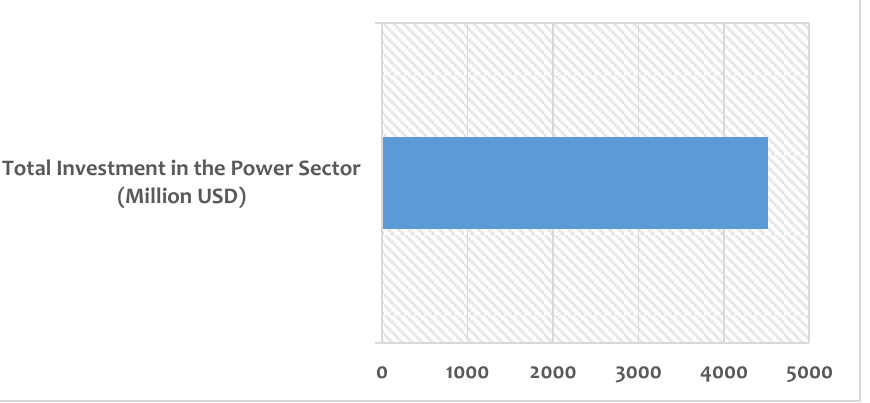
Figure 7. Renewable energy in the NDCs of the UAE. Data were collected from [51]. In 2018, emissions of 0.5655 million tons of CO 2 equivalent were avoided due to the installed capacity of solar energy in the UAE (Figure 8).